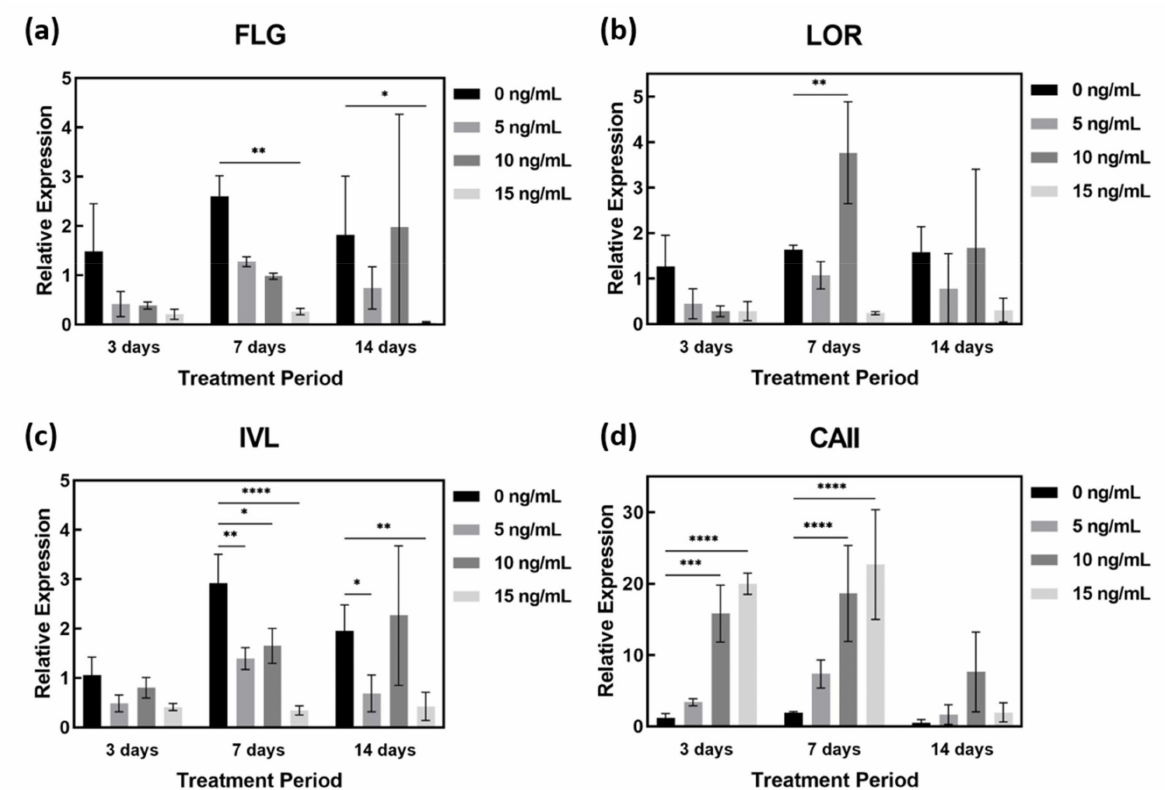
Figure 5. qPCR of IL-4- and IL-13-stimulated AD-HSE. AD-HSE treated with IL-4/IL-13 by concen- tration and period and controls: ( a ) FLG , ( b ) LOR , ( c ) IVL , ( d ) CAII ( n = 3; *, p < 0.05; **, p < 0.01; ***, p < 0.001; ****, p <